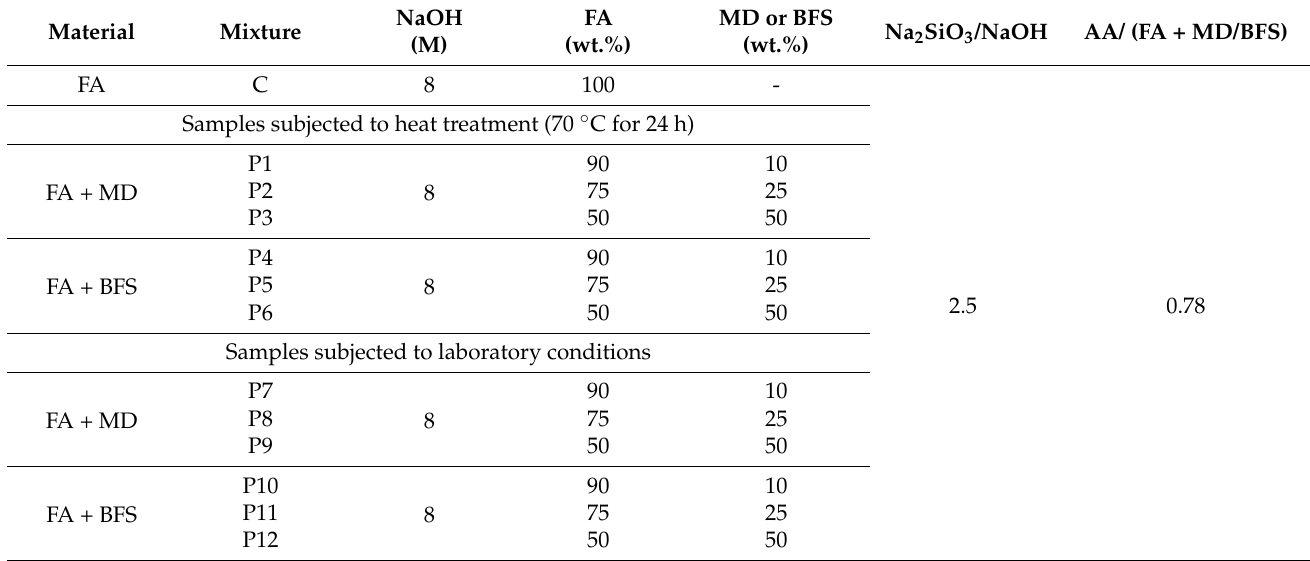
Table 3. Alkali-activated geopolymer binder mix